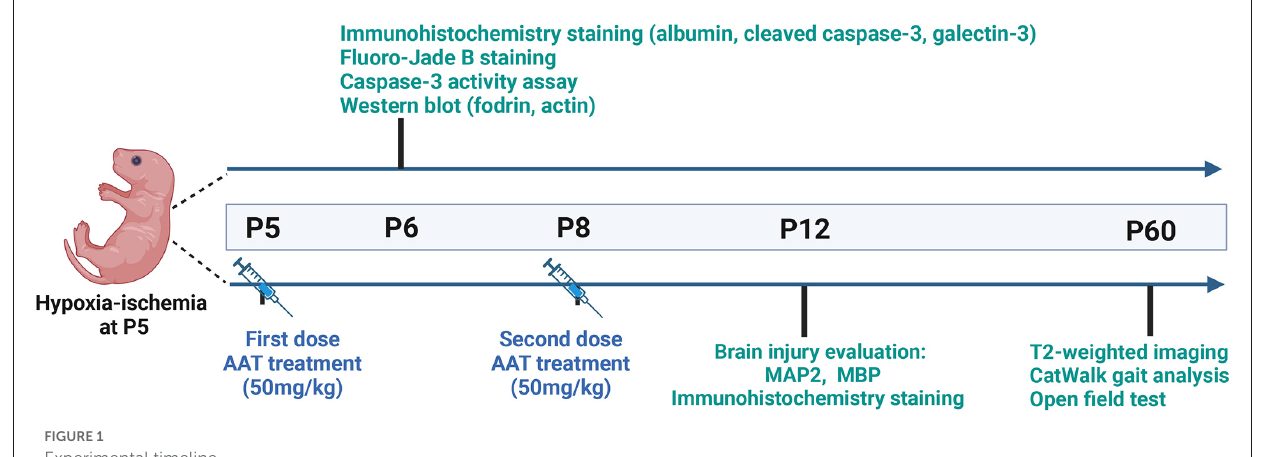
FIGURE1 Experimental